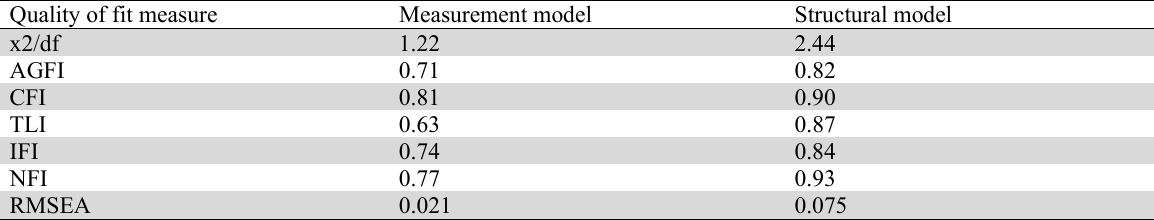
Fit Indices for Measurement and Structural Model.